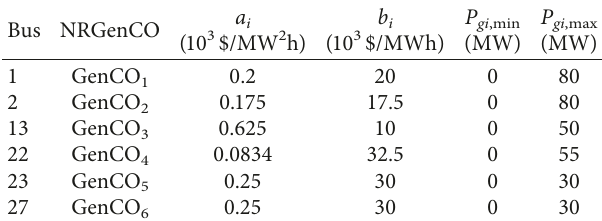
Table 3: Parameters of GenCOs’ bid